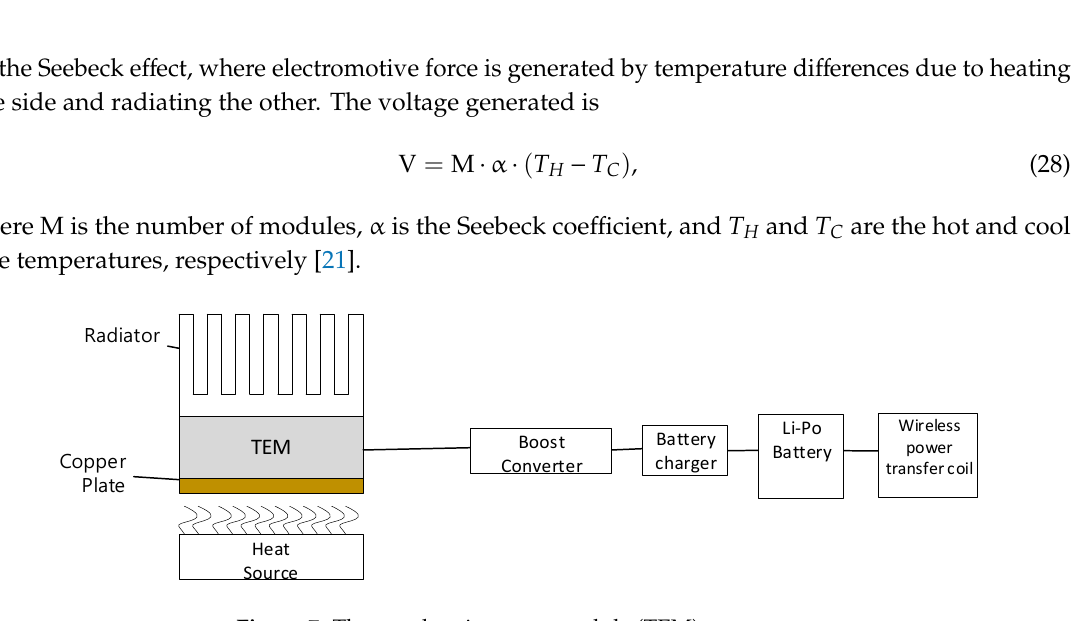
Figure 7 . Thermoelectric energy nodule (TEM) structure . Figure 7. Thermoelectric energy nodule (TEM) structure.